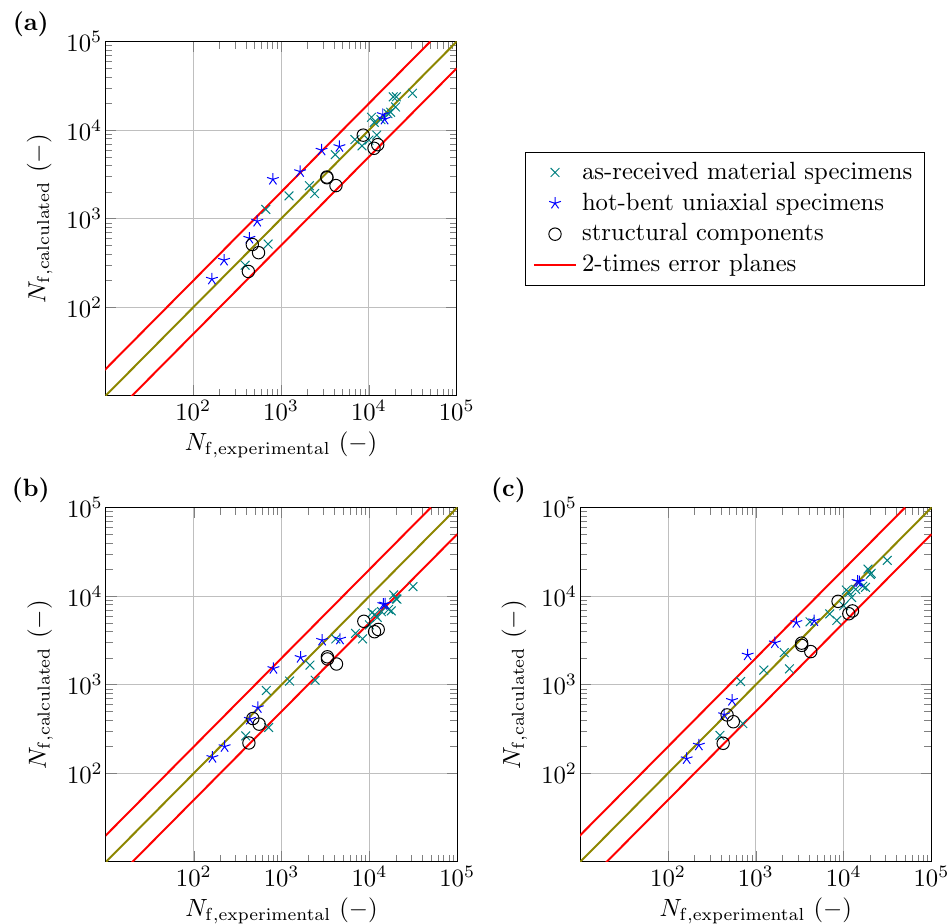
Figure 14. Comparison of the calculated and experimentally determined numbers of cycles to failure N f : ( a ) model with the regression parameters of the as-received material specimens; ( b ) model with the regression parameters of the hot-bent uniaxial specimens; ( c ) model with the regression parameters of the combined as-received material specimens and hot-bent uniaxial